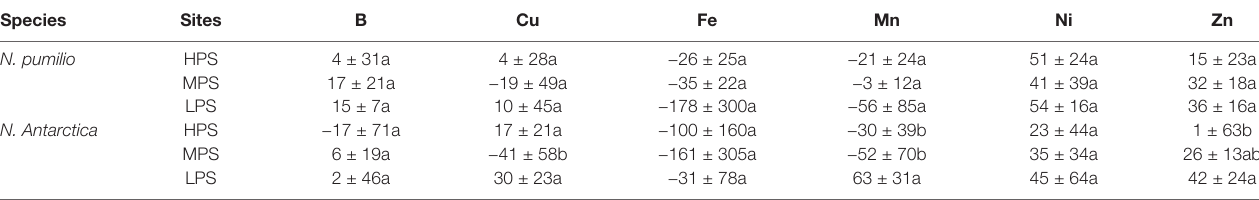
For each species, different letters for the same nutrient indicate significant differences (P < 0.05) between sites. HPS: highly productivity site; MPS: medium productivity site; LPS: low productivity site.